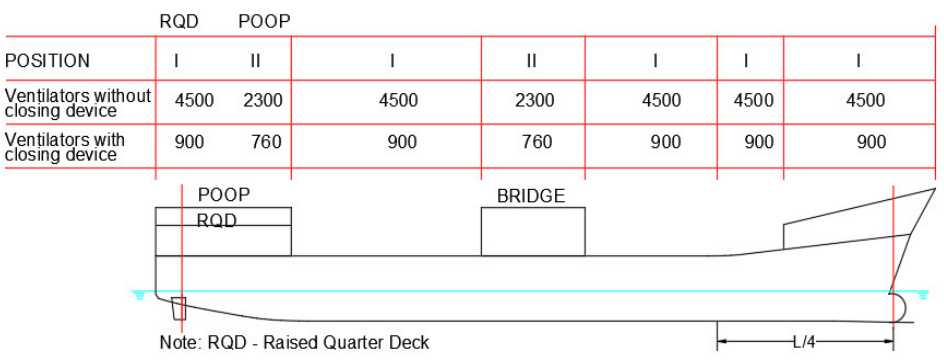
Figure 9. Requested height of ventilation openings above weather deck (data processed from [9,10]). Strength requirements for ventilation ducts located on the weather deck.